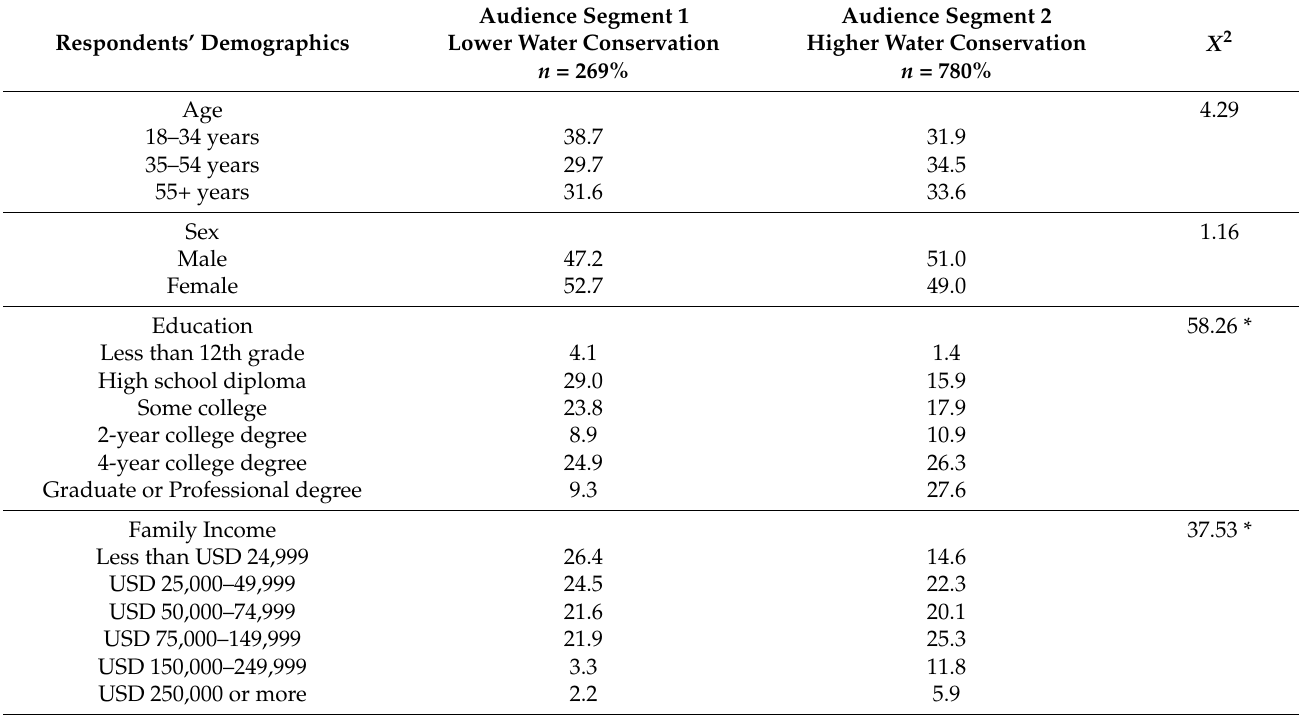
Table 2. Respondents’ level of water conservation behavior based on demographic